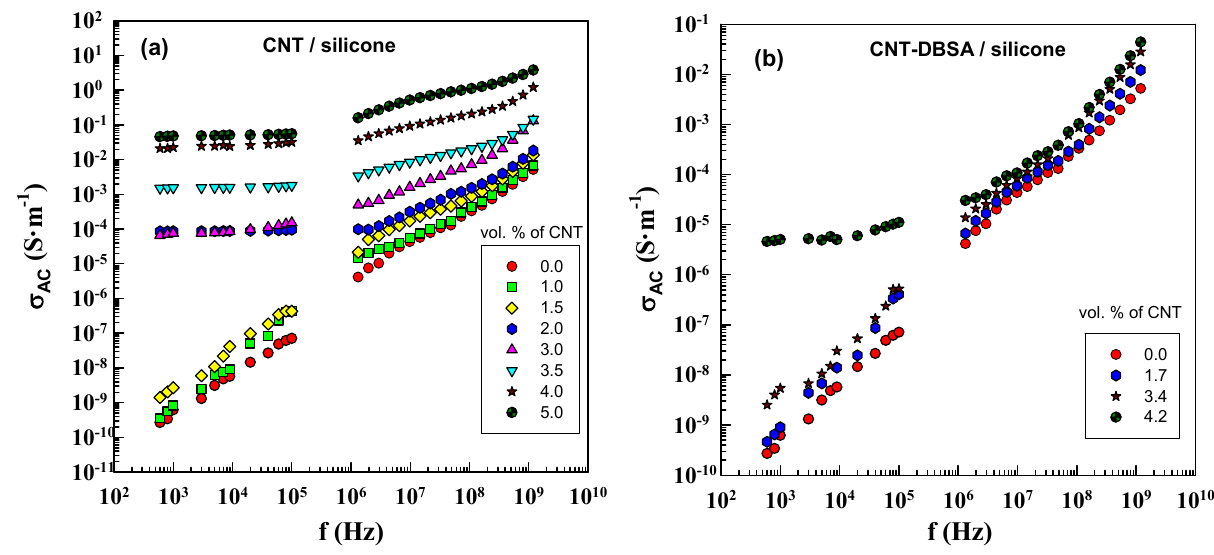
Figure 7. AC electrical conductivity as a function of frequency for ( a ) CNT/silicone (mechanical mixing) and ( b ) CNT–DBSA/silicone composites (sonication) with various filler